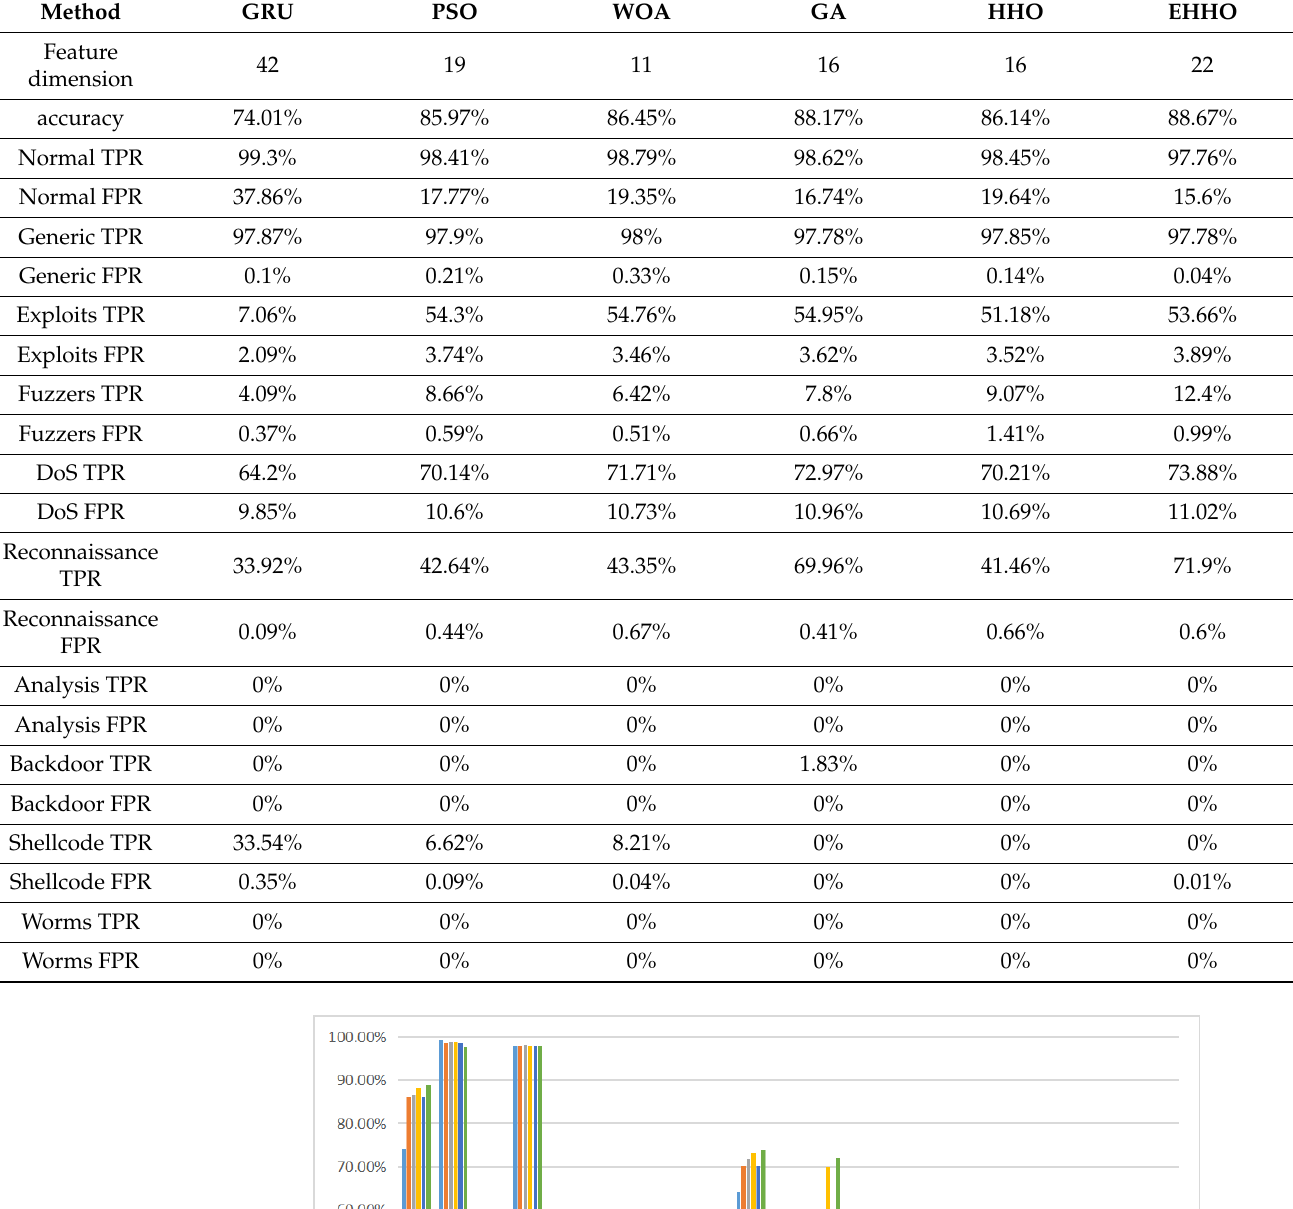
Table 10. The results of the UNSW-NB15 multi-classification experiment.